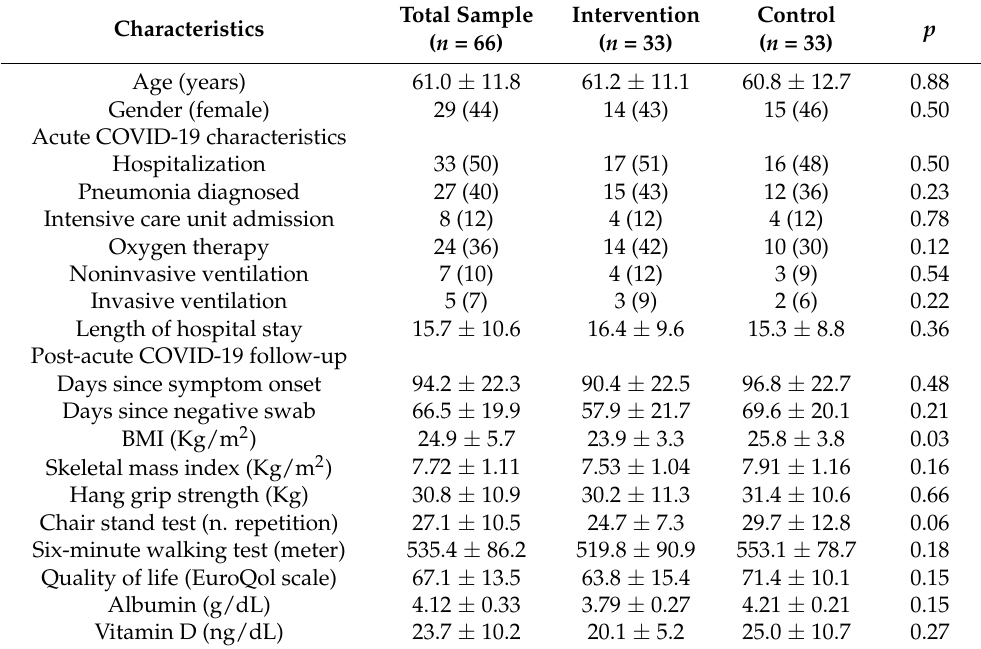
Table 2. Characteristics of study population according to intervention *. Characteristics